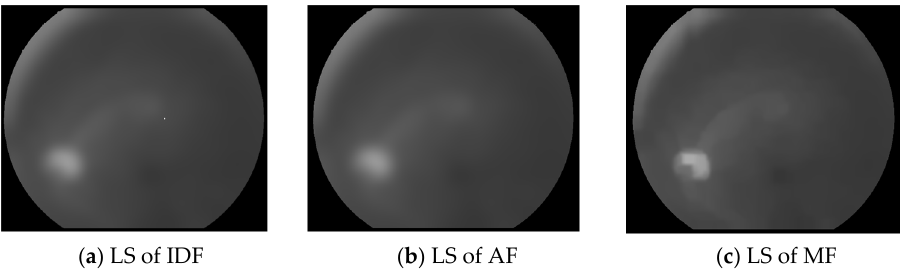
Figure 3. The LSs of the green channel in Figure 1 obtained using the three different filters.